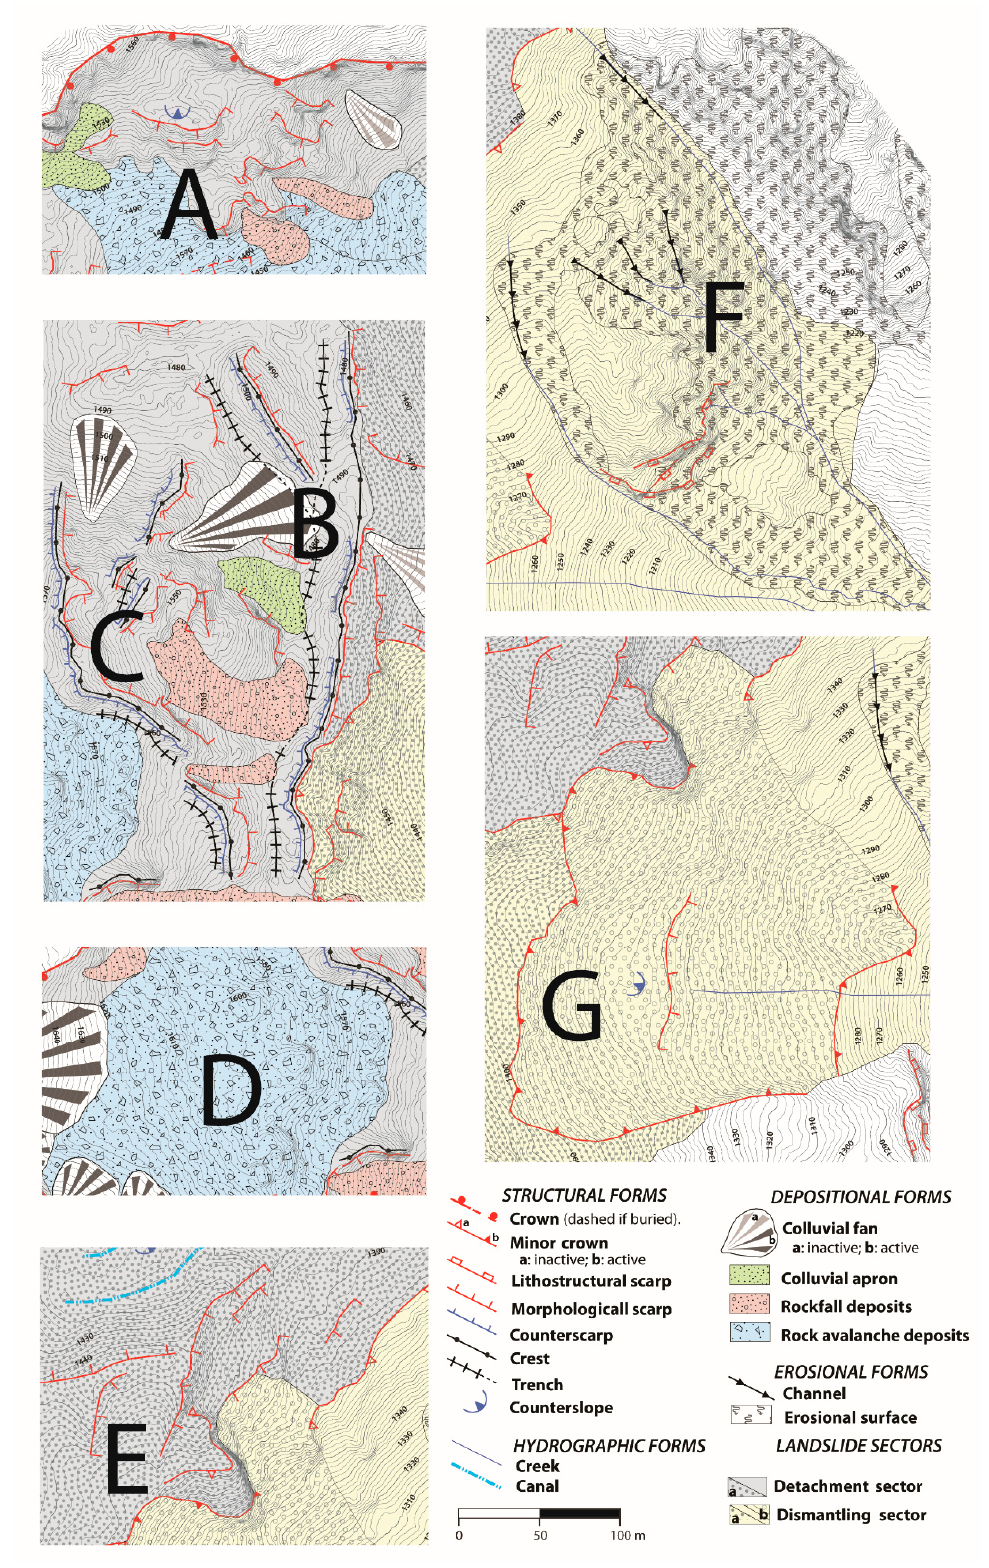
Figure 7. Extract from the geomorphological maps [15] corresponding to the 7 areas highlighted by the DEMs parameter analysis.